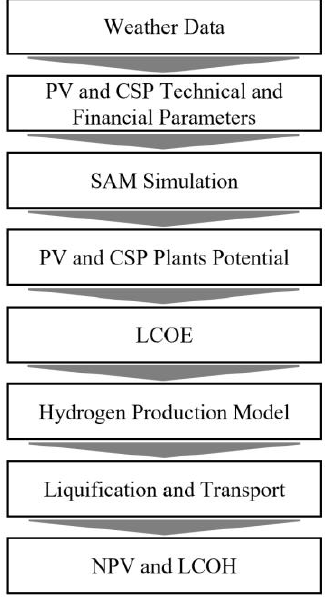
Figure 2. Study flowchart.